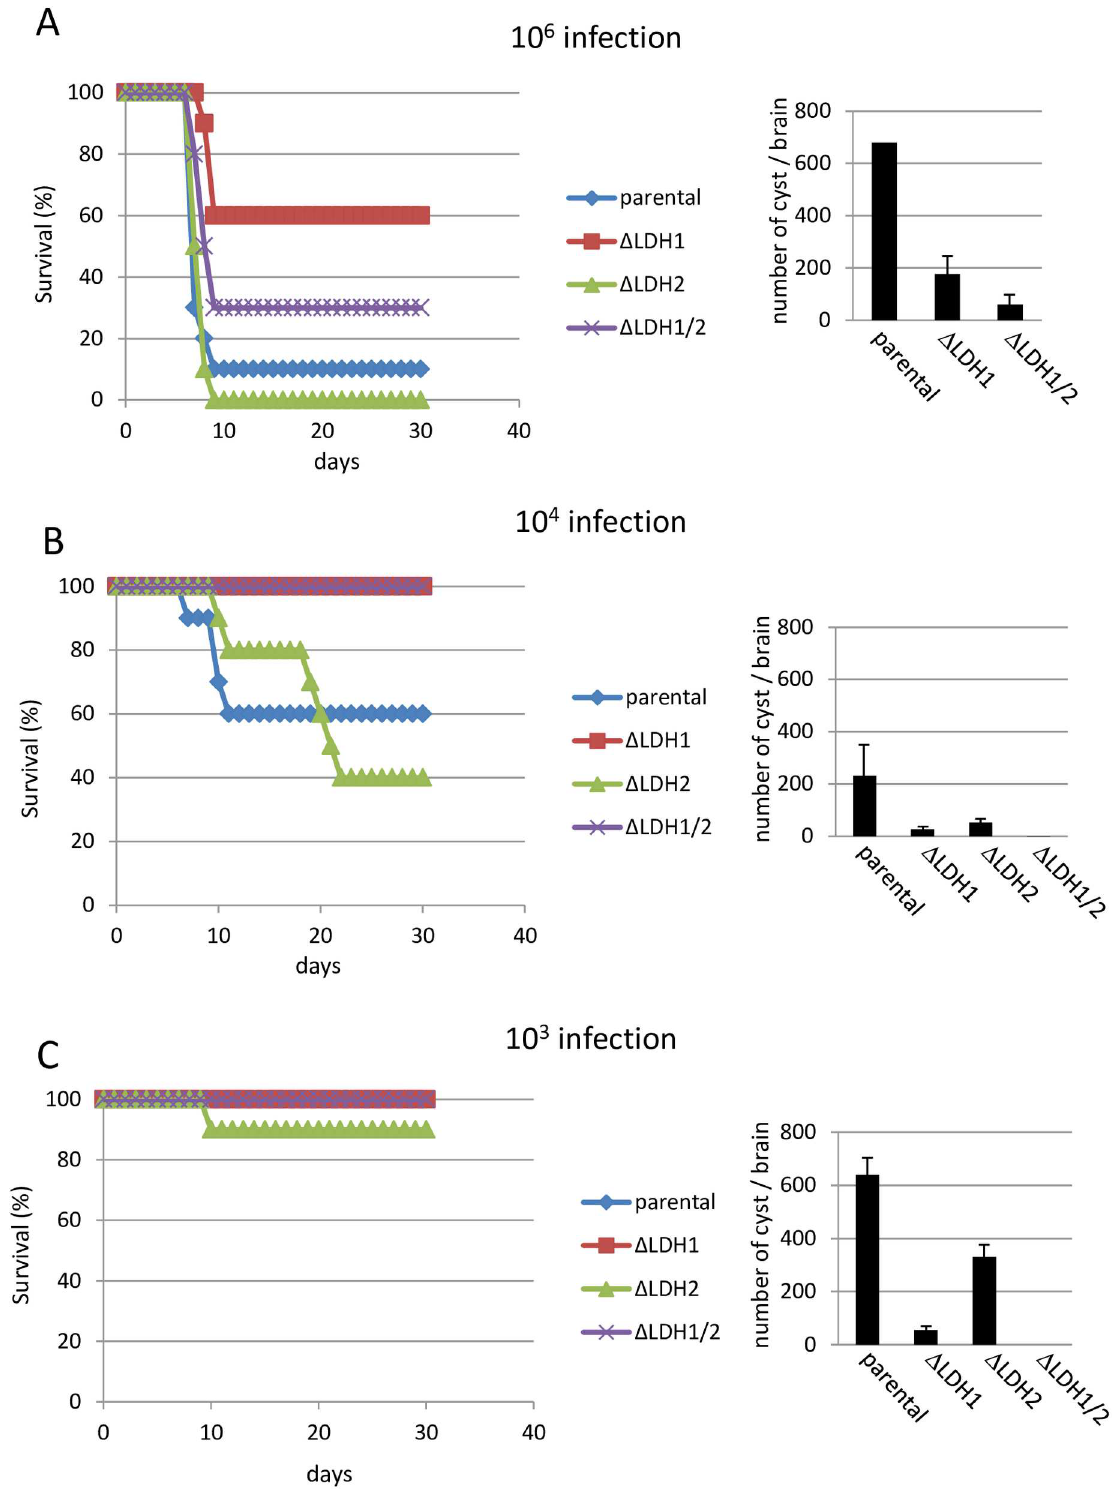
Fig 4. Virulence and cyst formation of LDH knockout strains in Balb/c mice. Left panelsshow survival of mice infected with indicatednumberof parasites(A: 10 6 , B: 10 4 , C: 10 3 ). Right panels show the numberof cyst in brains of survived mice.